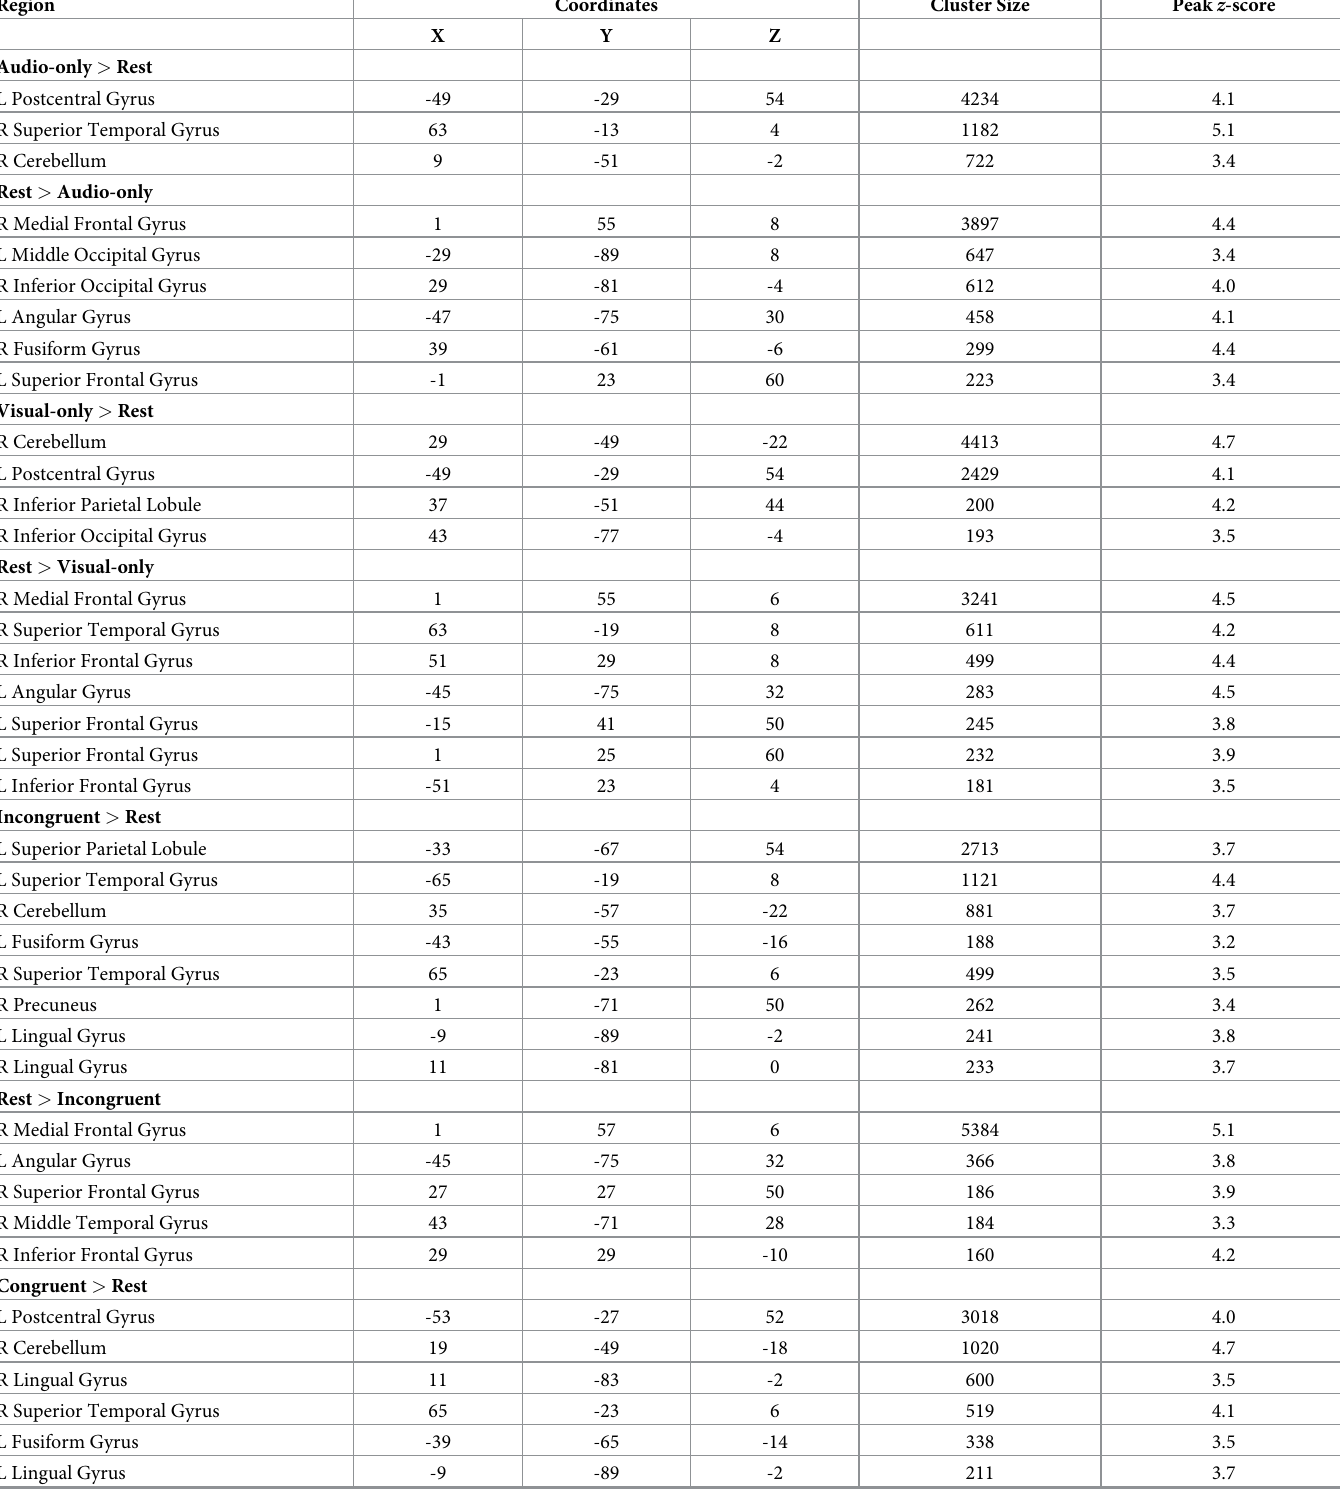
Table 1. Significant regions and peak coordinates for each condition compared to rest contrasts.